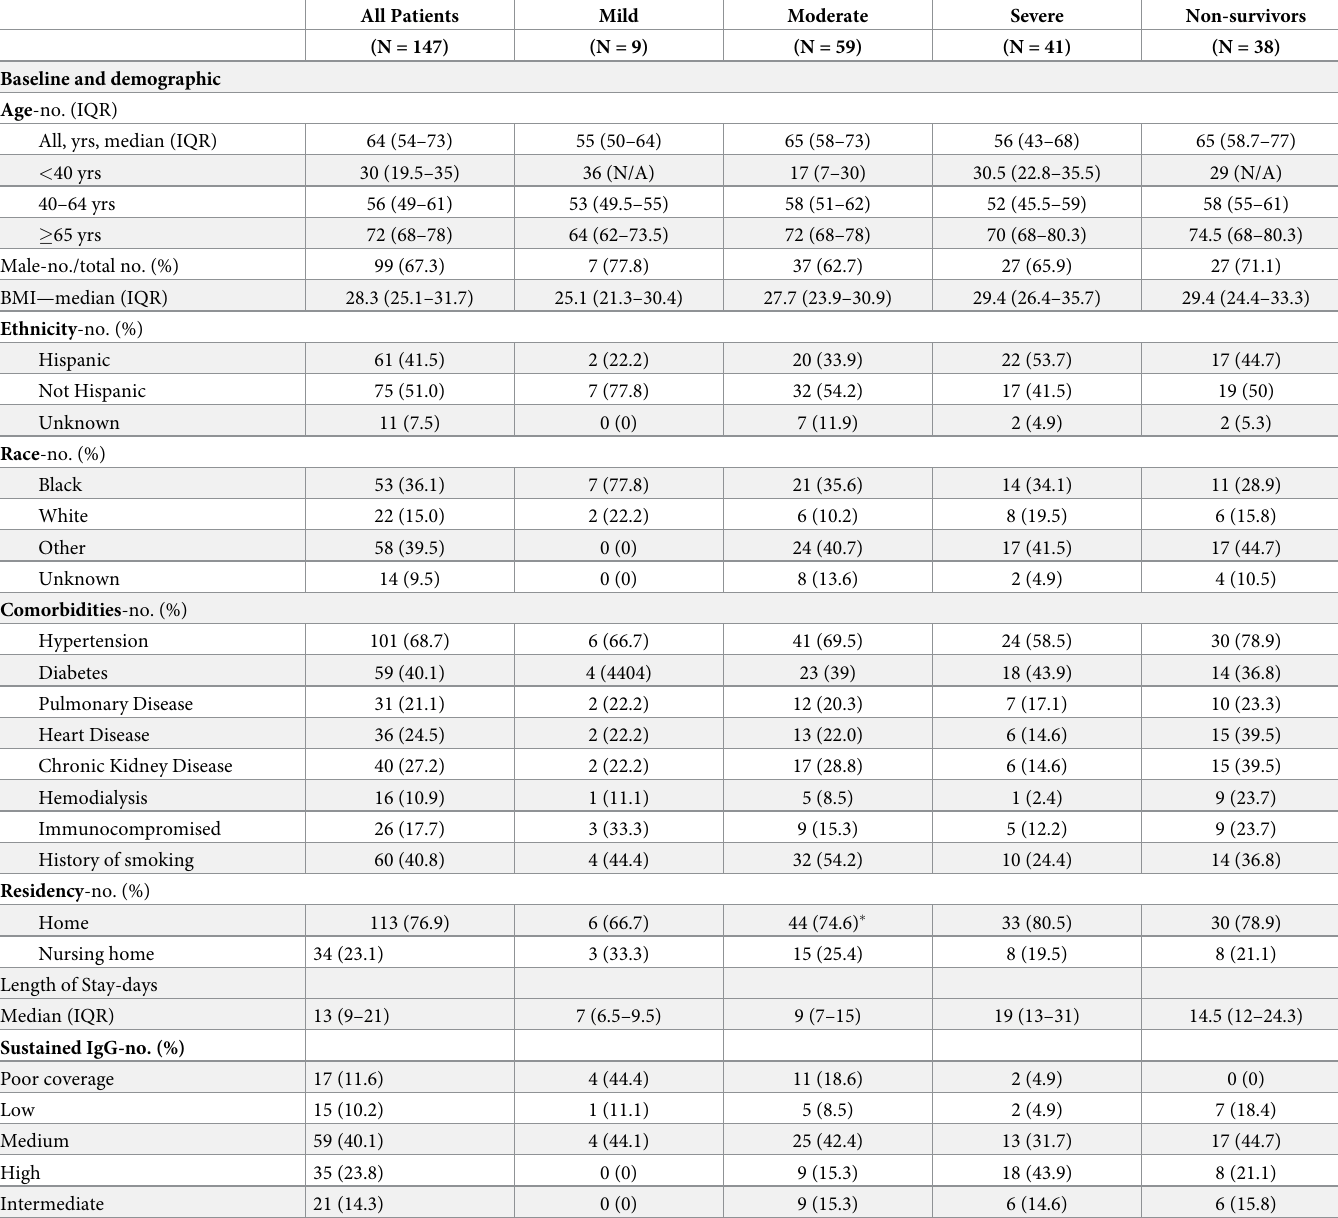
Table 1. Patient Characteristics. Patients are grouped by outcome; survivors disease severity is categorized based on maximal oxygen supplementation during hospitali- zation. Mild: room air; Moderate: nasal cannula, or non-rebreather; Severe: high flow oxygen therapy or mechanical ventilation. BMI reported as kg/m2.a � one subject in this category was